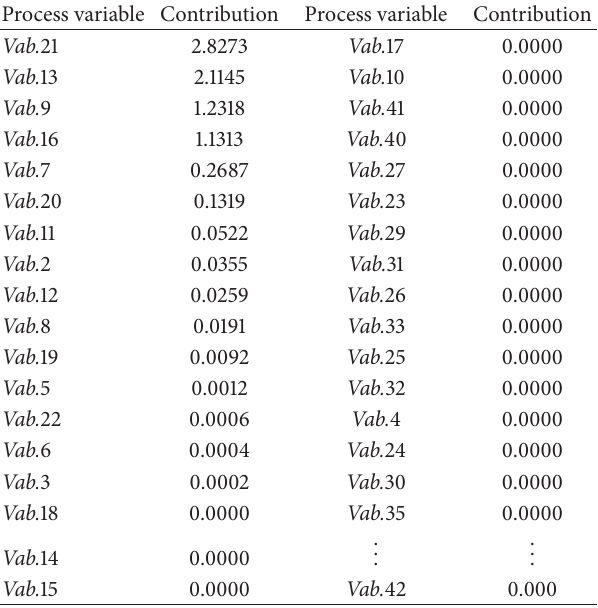
Table 3: The contributions of 53 process variables to fault